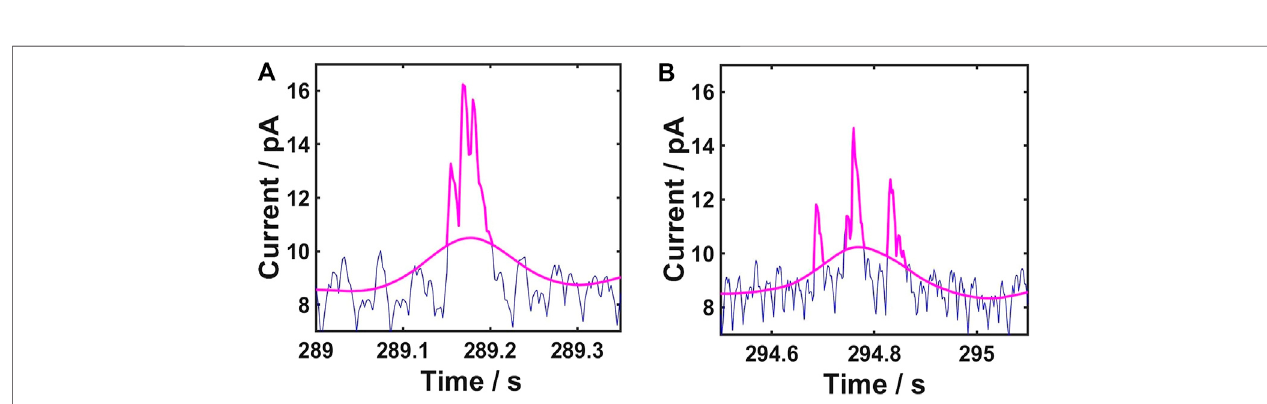
FIGURE 3 | Rule to identify single and multiple AgNP impact (A) Troughs of a cluster of spikes above the baseline indicate that the spike clusters are from multiple impact events of a single AgNP (B) Troughs of a cluster of spikes below the baseline indicate that the spike clusters are individual spikes from multiple single AgNPs.